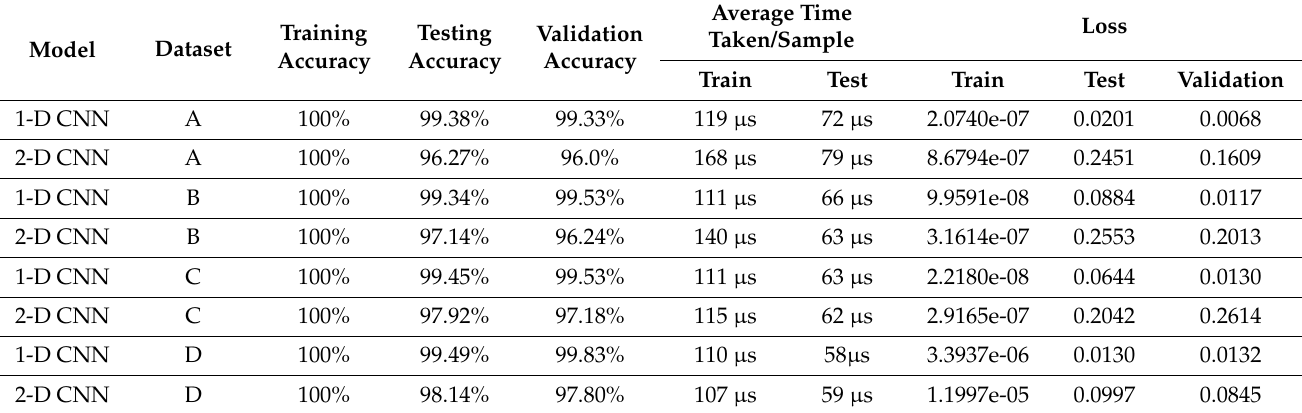
Table 5. Model accuracy and